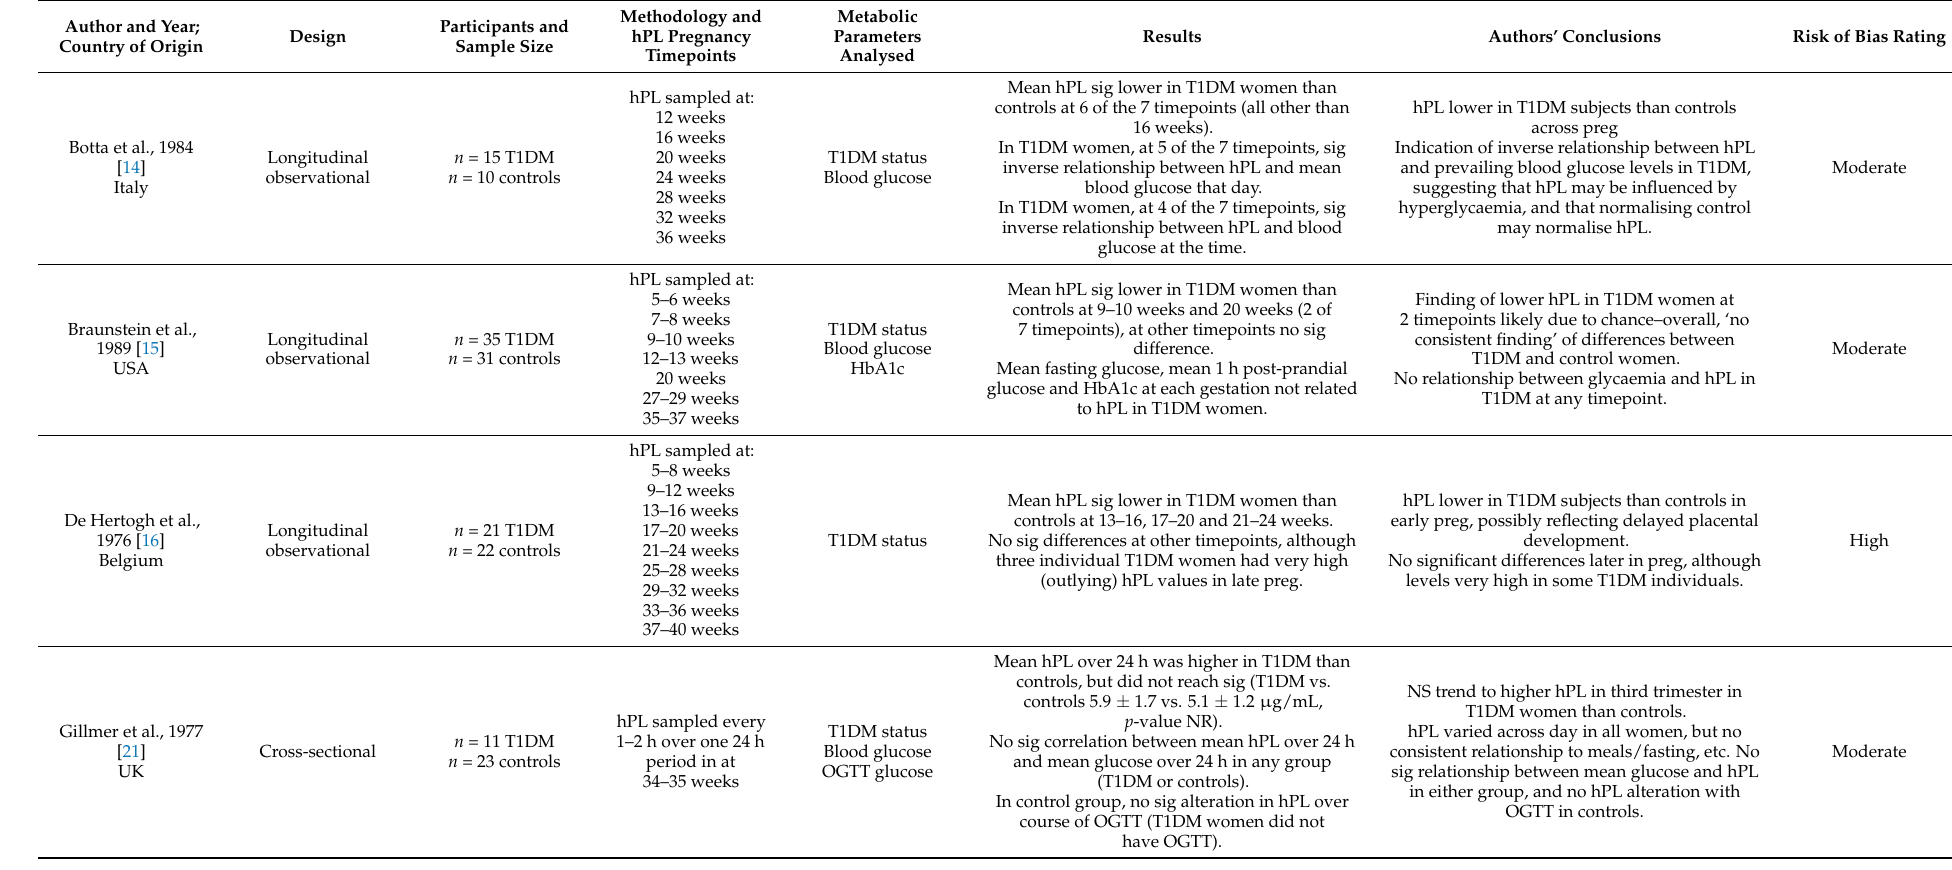
Table A1. Studies examining hPL in pregnancies affected by pre-gestational type 1 diabetes mellitus—12